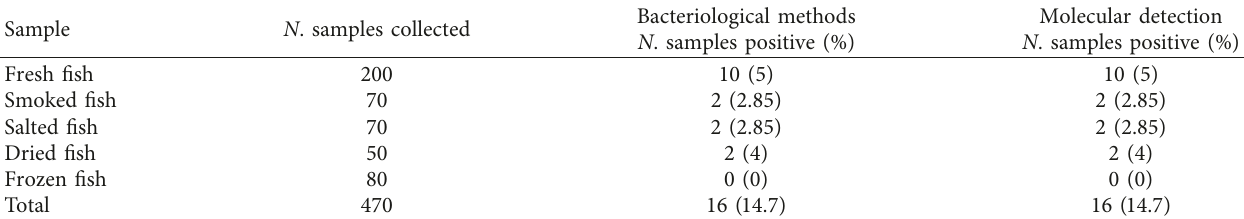
No significant difference was observed between samples ( p > 0 . 05).